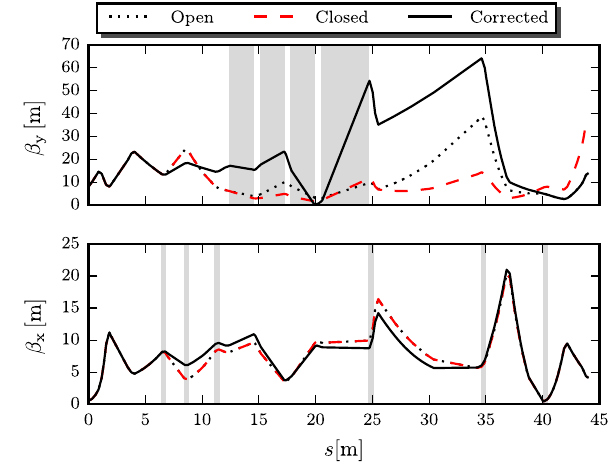
FIG. 6. Evolution of the β -functions in dependence on the longitudinal coordinate s . The undisturbed state (dotted) is compared to the disturbed state with (solid line) and without (dashed) application of the correction. Grey areas in the upper plot mark the position of the variable-gap undulator segments. In this example, a different set of correction magnets is used. Their positions are indicated in the lower plot. Note that at the end of the beam line the corrected optical functions agree with the open